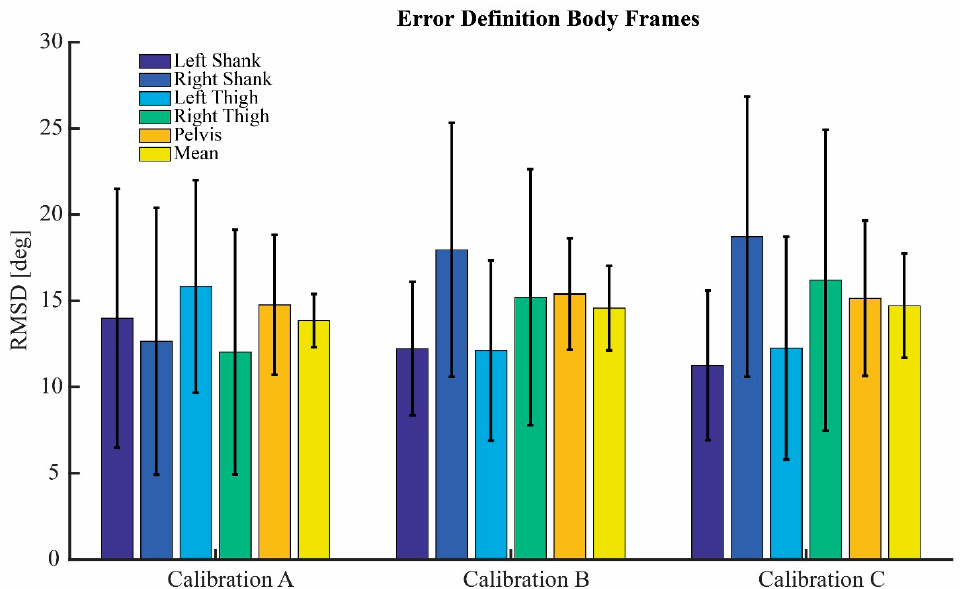
Figure 4. Error of the definition of the body frames. Root-mean-square differences (RMSD) of all body segments for the three different calibrations, see Figure 3 for calibration movements.